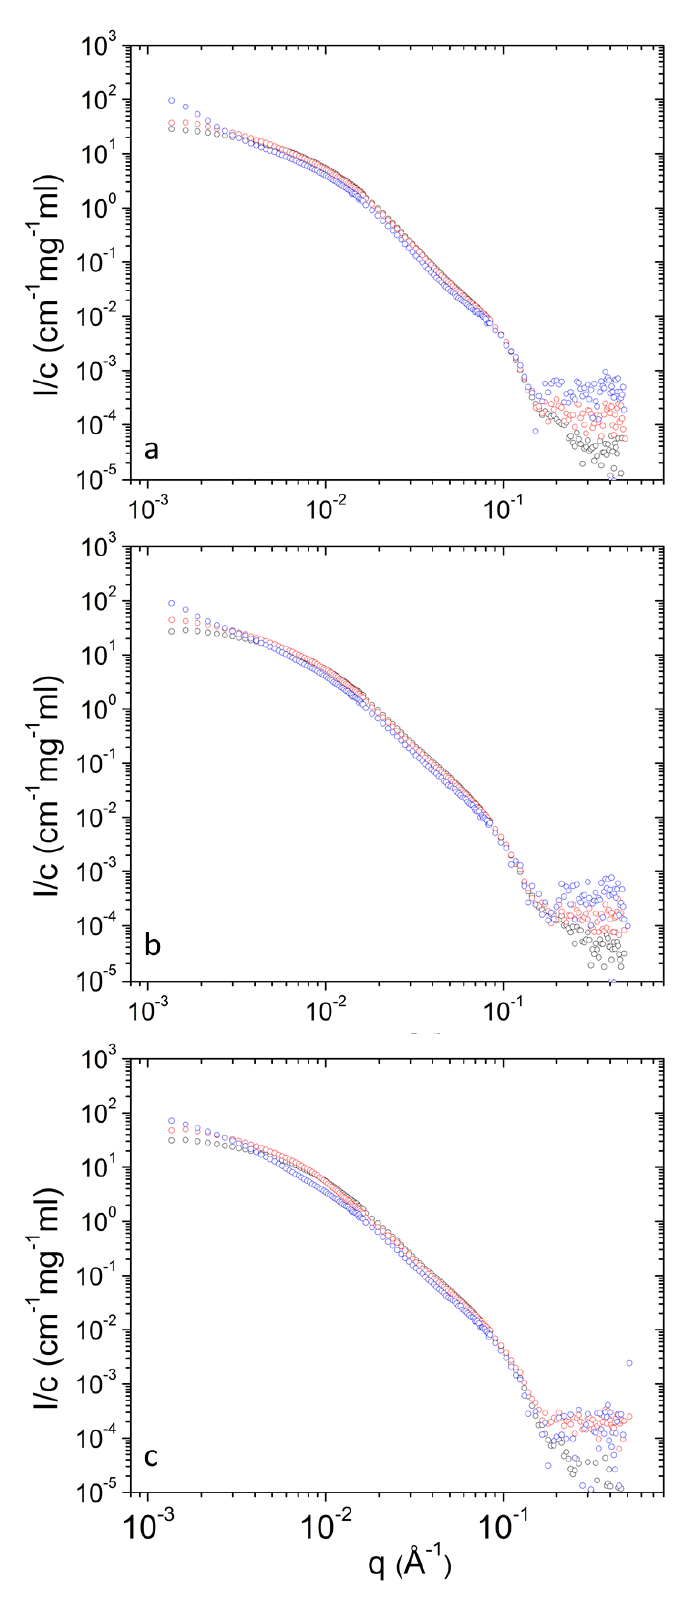
Figure 7. Concentration-normalized SANS profiles from DPPC/PEO-b-PCL1 at 3 (blue), 10 (red) and 30 (black) mg mL −1 at different temperatures i.e., ( a ) 25 °C, ( b ) 37 °C and ( c ) 45 °C.